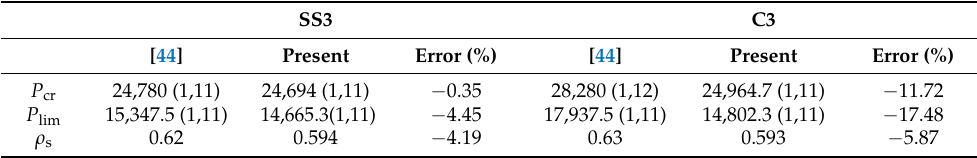
Table 3. Comparisons of buckling results (N/m) for the stringer-stiffened cylinder XS-1 under axial load. SS3 C3